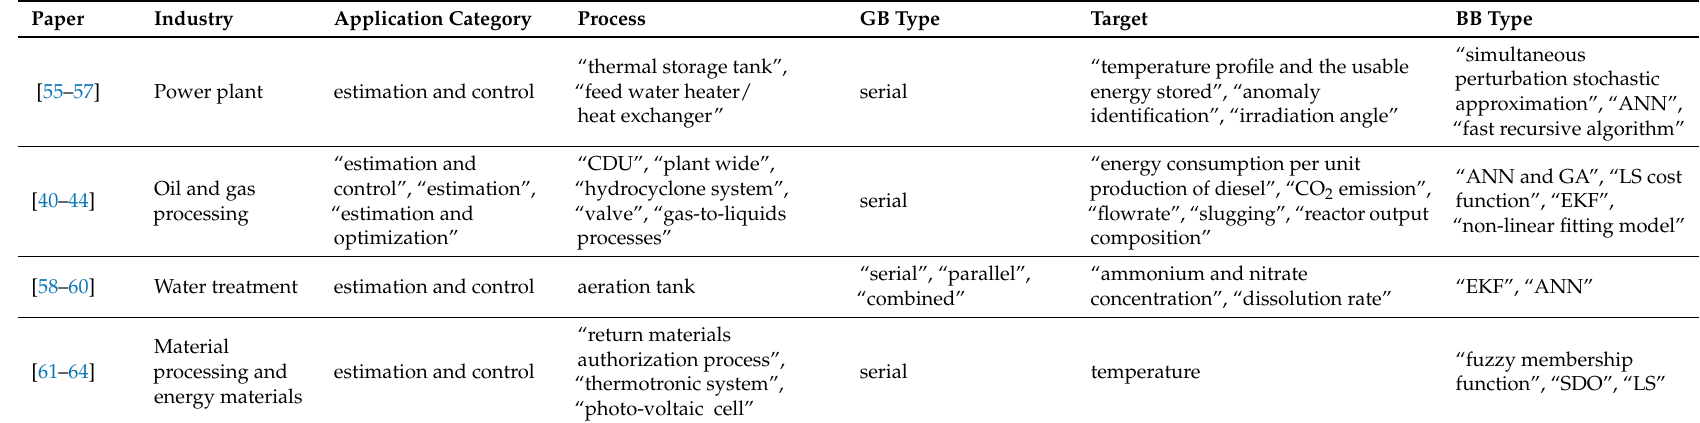
Table 2. GB modeling application in power plant, oil and gas industry, waste water treatment, and material process and energy materials.